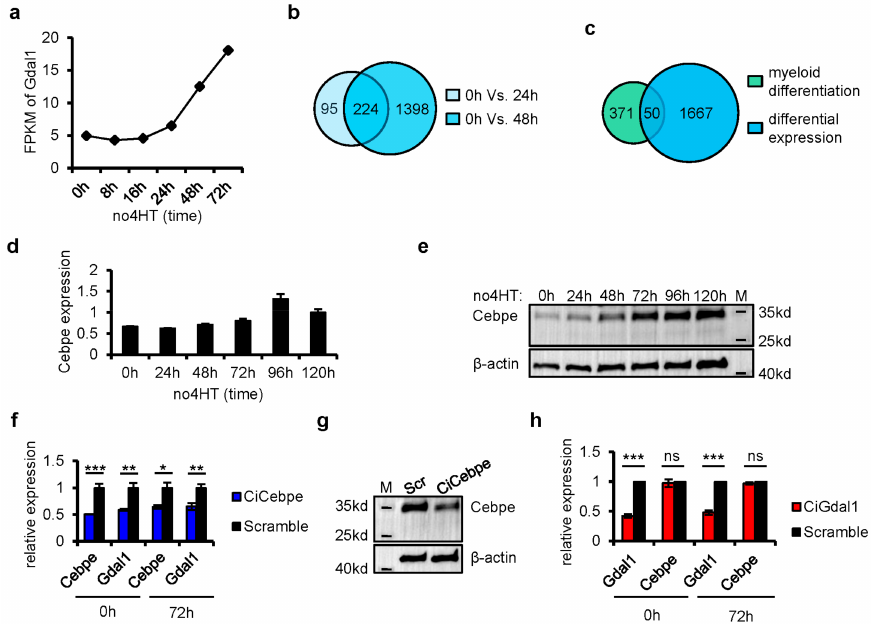
Figure 3. Knockdown of Cebpe led to down-regulation of Gdal1, but not vice versa. ( a ) Synthesis rate of Gdal1 is represented as FPKM of nascent Gdal1 RNA after the initiation of granulocyte differentiation. ( b ) Genes with changes of synthesis rate at 24 h and 48 h after the initiation of myeloid differentiation compared with 0 h. ( c ) Overlapping the differentially expressed genes shown in ( b ) with all the 421 genes annotated by Gene Ontology (GO) consortium that are directly related to myeloid differentiation. ( d , e ) Gene expression dynamics of Cebpe in RNA level by qPCR and in protein level by Western blotting during the differentiation of CSH3 cells. ( f ) Knockdown of Cebpe by CRISPRi resulted in down-regulation of Gdal1 in both differentiating (3 days after 4HT withdrawal) and differentiation arrest (with the presence of 4HT) CSH3 cells. Relative RNA level was analyzed by qPCR. ( g ) Knockdown of Cebpe by CRISPRi was confirmed in protein level in differentiating CSH3 cells by Western blotting. ( h ) Knockdown of Gdal1 did not affect the expression of Cebpe in both differentiating (3 days after 4HT withdrawal) and differentiation arrest (with the presence of 4HT) CSH3 cells. RNA levels of genes are analyzed by qPCR. Ci is short for CRISPRi, qPCR data is represented as mean ± SEM of 3 replicates. ns p > 0.05, * p ≤ 0.05, ** p ≤ 0.01, *** p ≤